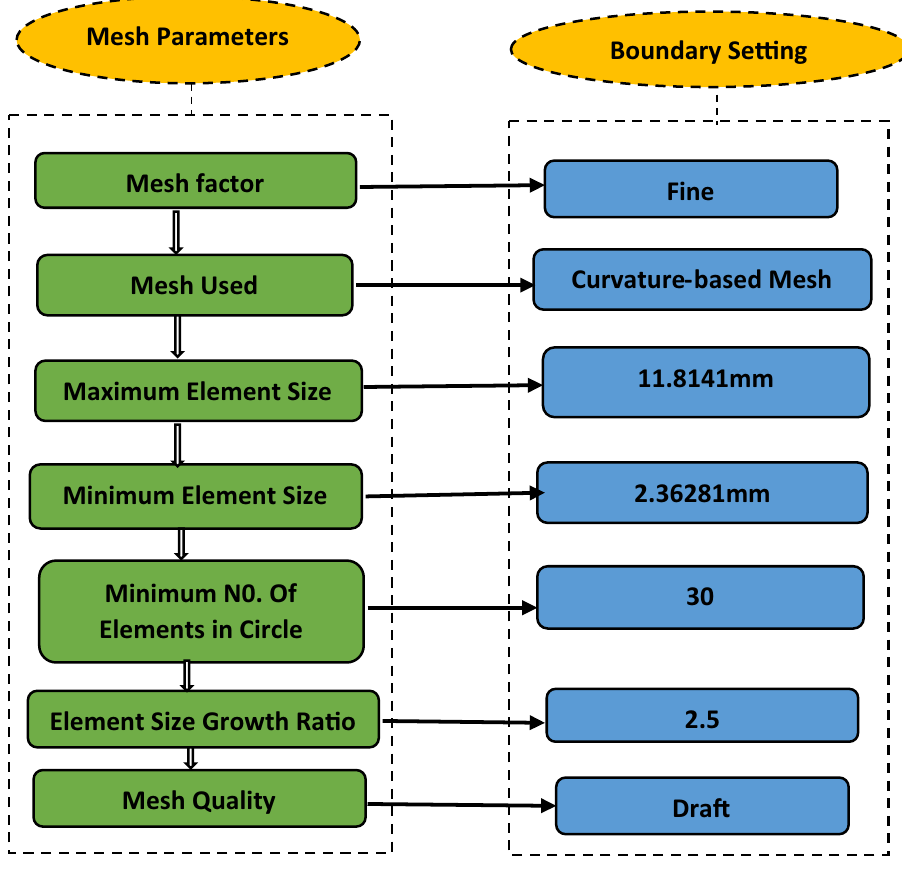
Figure 18. Mesh setting sequence.